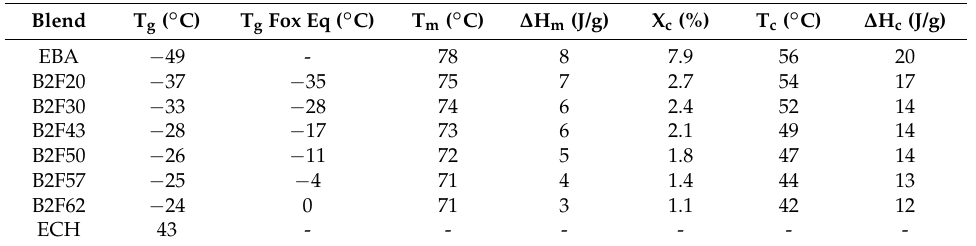
Table 3. Some parameters obtained from DSC thermograms of the EBA copolymer, the ECH resin, and their binary blends.